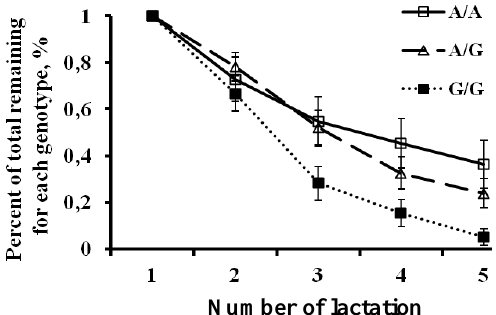
Figure 2. Temporal changes in the percent of total remaining for each TNF  -824A/G genotype per number of lactations in Black Pied cattle which is likely due to differential culling of herd. n = 2- 46 animals per point. The standard error of the mean for genotype frequencies is displayed. The frequency for each genotype in primiparous heifers is taken as 100 percent.